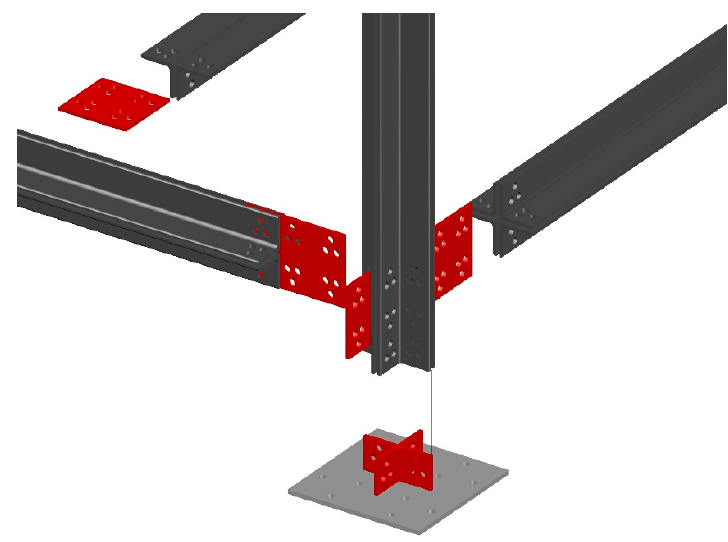
Figure 5. Connection of columns and beams with Greek cross shape—Patent [11].